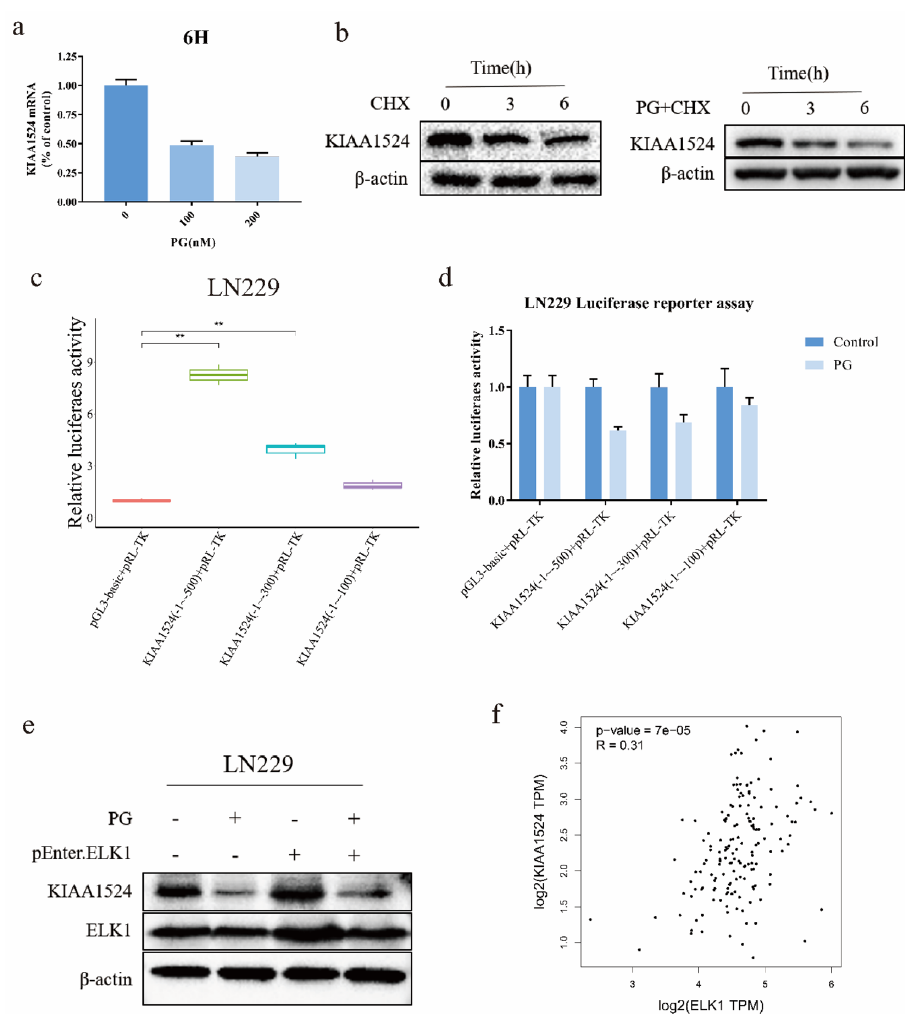
Figure 5. Prodigiosin suppresses KIAA1524 transcription by disrupting the binding of Elk-1 to the promoter of KIAA1524. ( a ) Quantification of KIAA1524 mRNA level in LN229 cells treated with or without PG for 6 h. ( b ) The protein level of KIAA1524 in LN229 cells treated with 100 µg/ml CHX with or without PG for 0 h, 3 h or 6 h. ( c , d ) Effects of PG on KIAA1524 promoter activity. LN229 cells were co-transfected with different promoter regions before being treated with PG. Cell lysates were prepared for analysis of luciferase activity. (* p < 0.05. ** p < 0.01). ( e )Ectopic expression of ELK1 reversed the effects of PG in GBM cells: ELK1 was up-regulated by transfection. Cells were treated with or without PG at 100 nM for 24 h and analyzed by western blotting. ( f ) Bioinformatics correlation analysis between KIAA1524 expression and